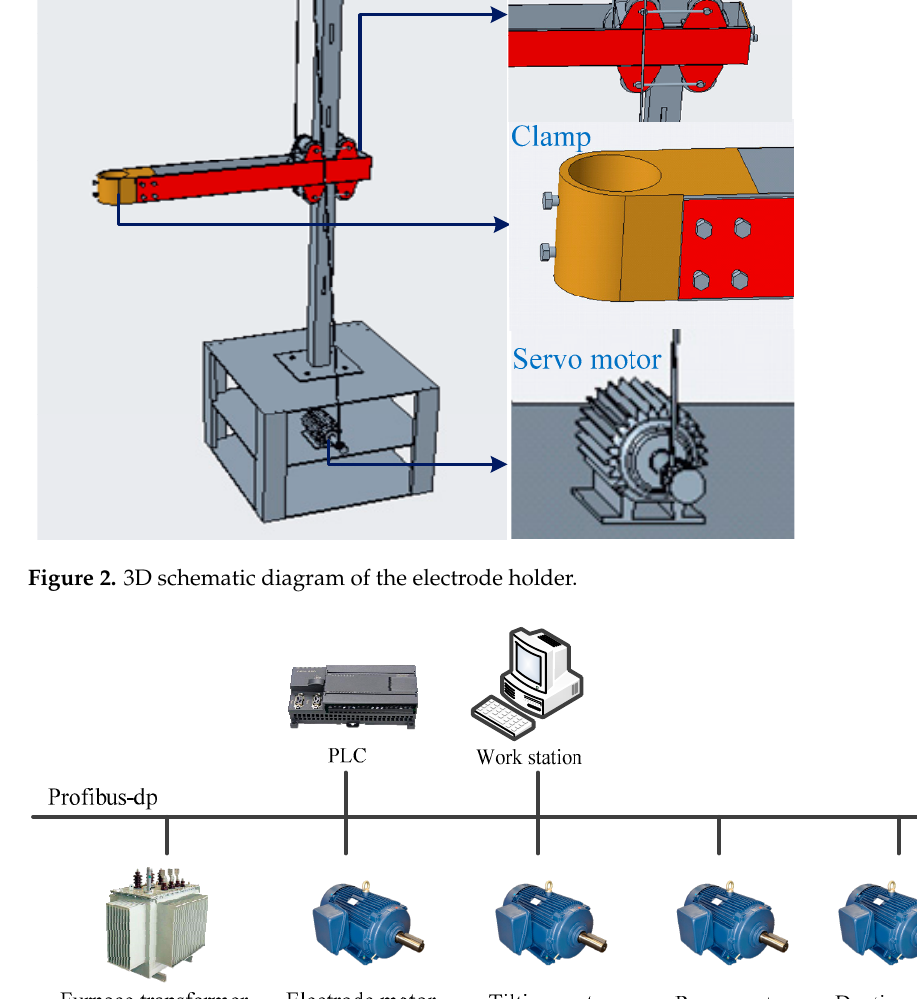
Figure 2. 3D schematic diagram of the electrode holder.